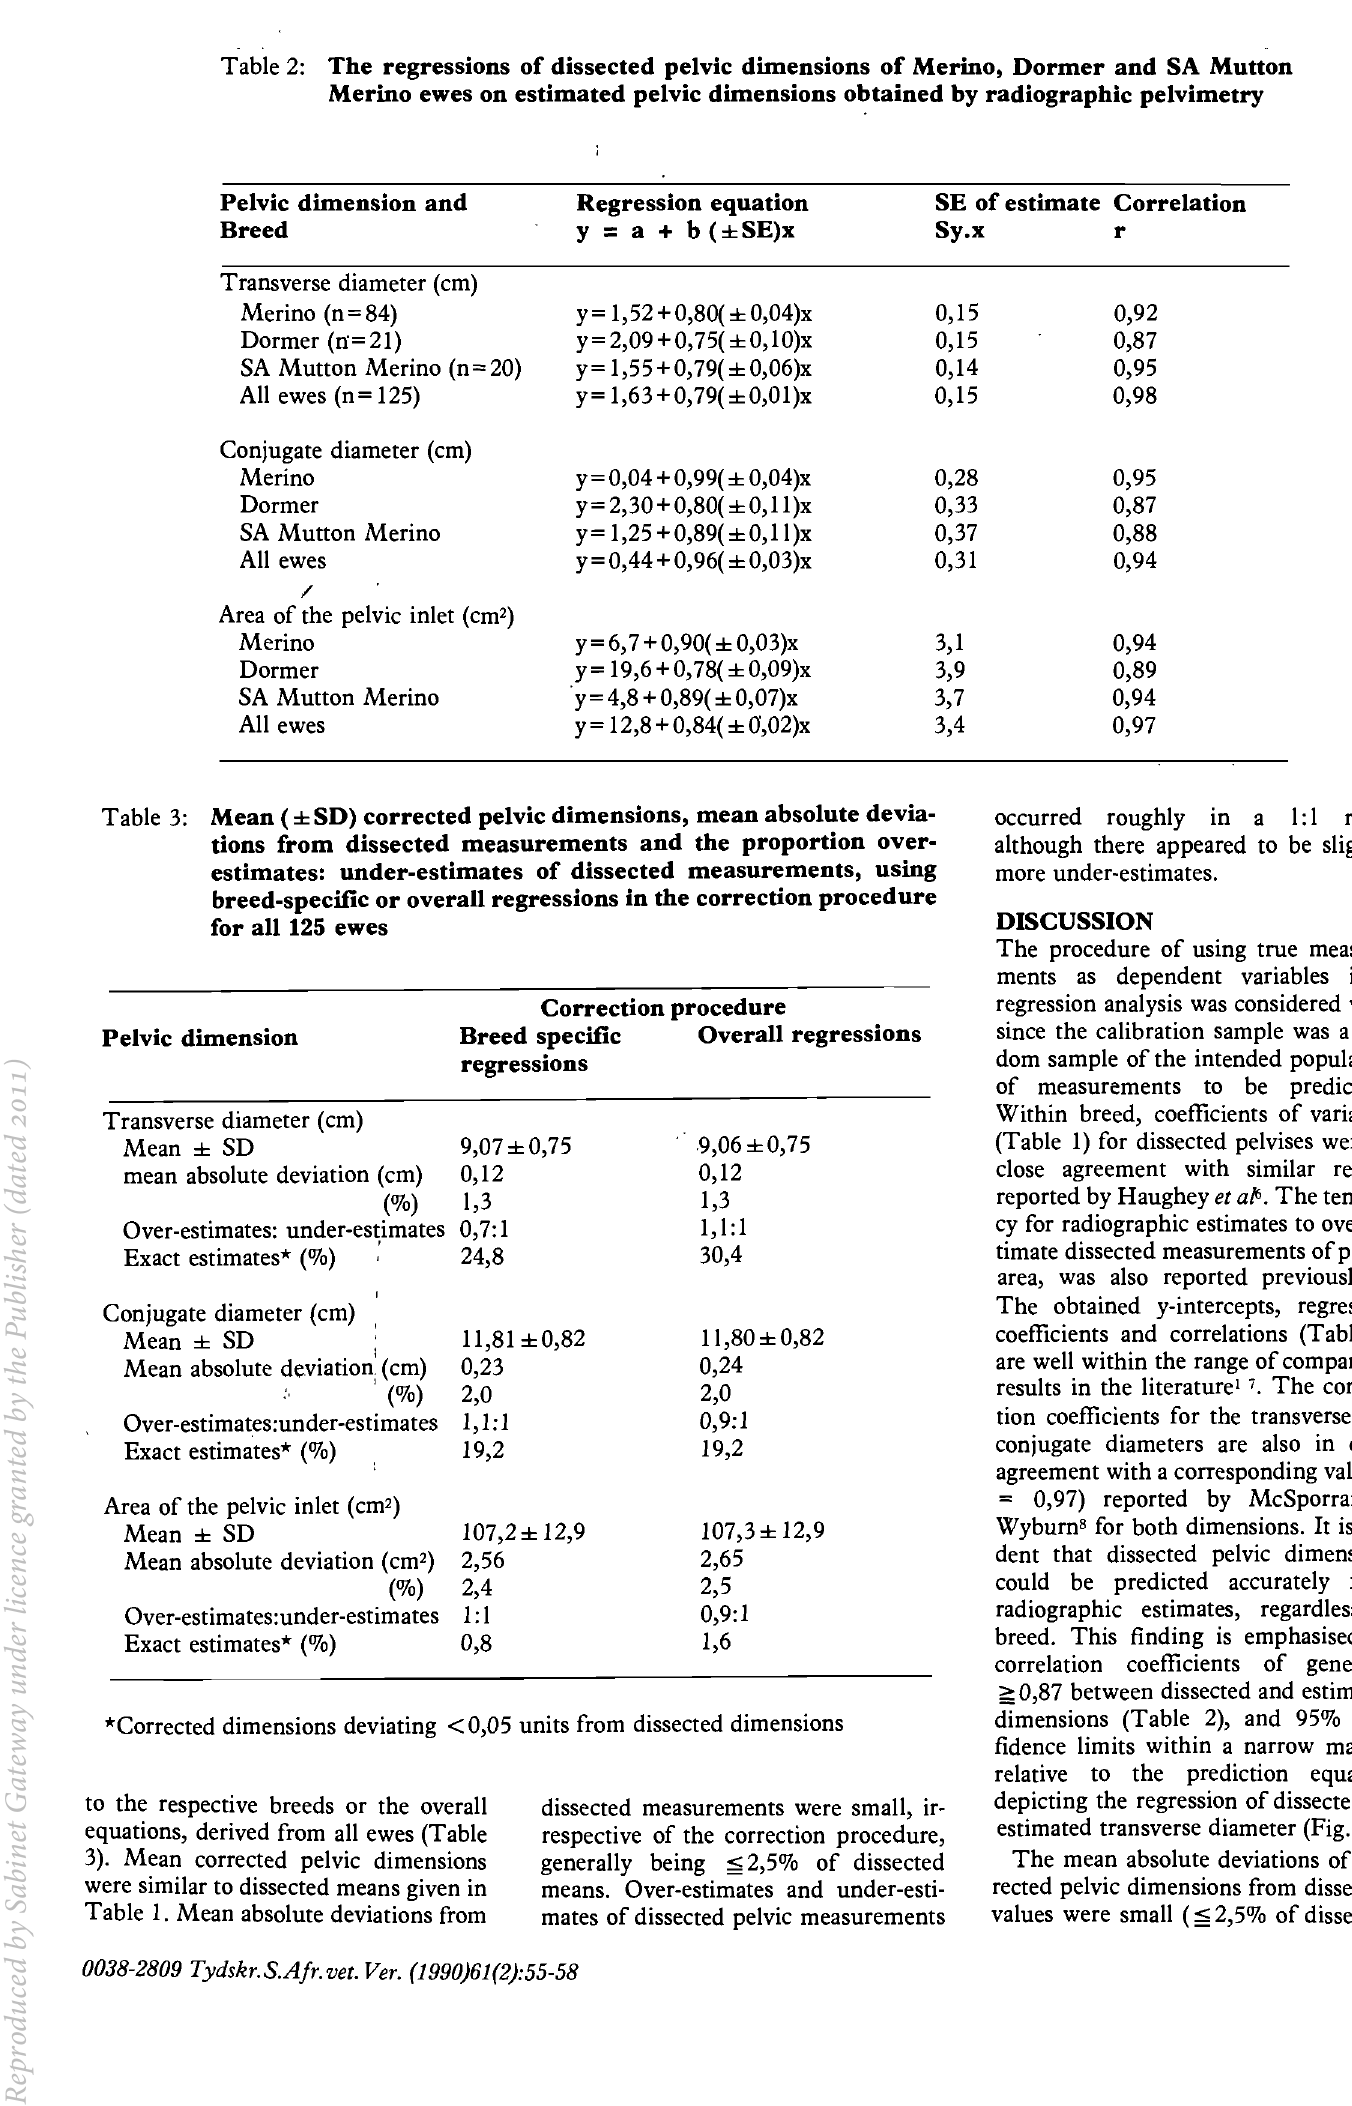
Table 2: The regressions of dissected pelvic dimensions of Merino, Dormer and SA Mutton Merino ewes on estimated pelvic dimensions obtained by radiographic pelvimetry